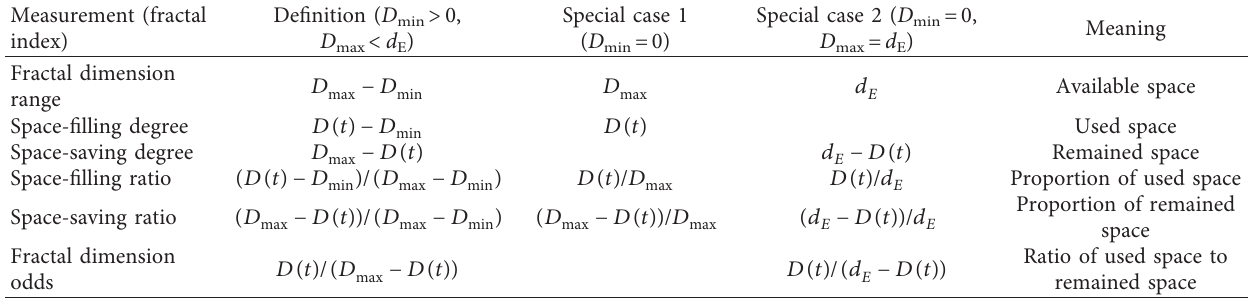
Table 1: A set of spatial measurements based on the fractal dimension of urban growth and form. Measurement (fractal